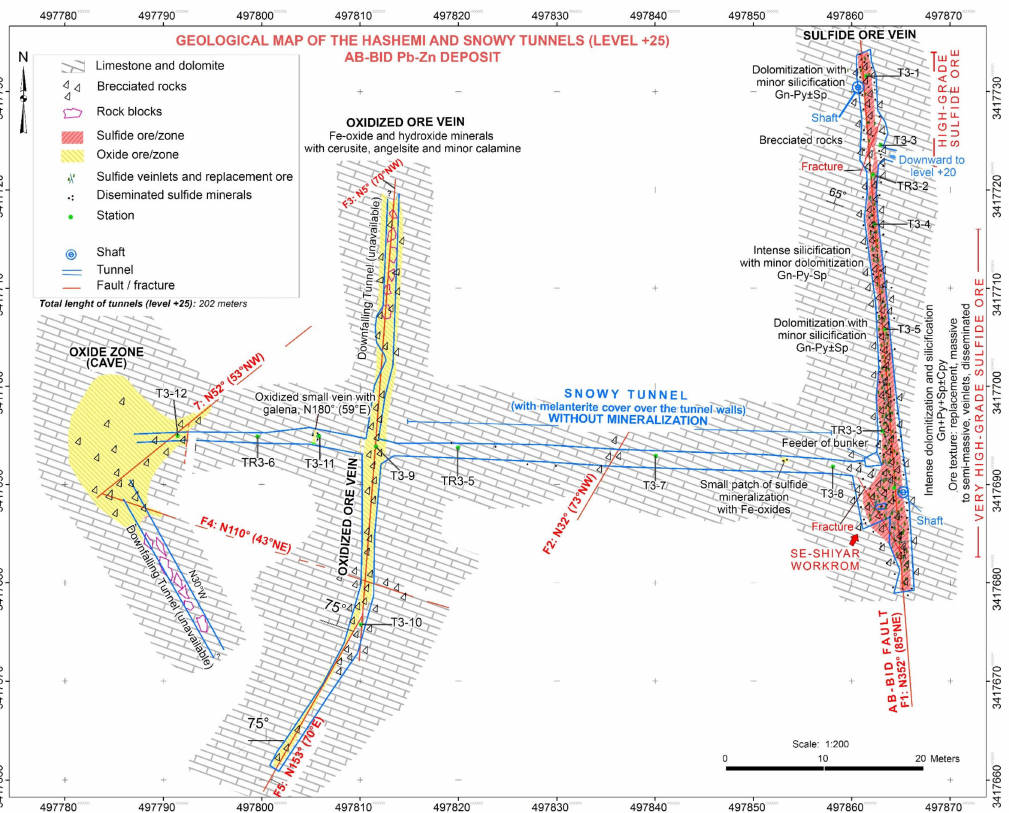
Figure 6. Geological map of the New Mine (Hashemi) and Snowy tunnels, +25 mining level [8]. The strike-slip faults in domino structures are the main ore-controlling structure in the Ab-Bid deposit. The major ore veins can be divided into the lateral brecciated-veinlets ore zone (LOZ) and the central sulfide-rich ore zone (COZ) in this deposit (Figure 8). The LOZ, observed on both sides of the main ore veins (fault zone), is extended 1 to 3 m wide and is graded into unbroken carbonate rocks. This zone includes very low-grade sulfide mineralization and is characterized by dolomitized and silicified limestone with small sulfide-bearing dolomite-quartz veins and veinlets, disseminated and replacement sulfides, brecciated clasts, and a series of barren joints. On the microscopic scale, the brecciated clasts are intensely fractured and cut by microfractures infilled with Fe-dolomite, quartz, pyrite, and